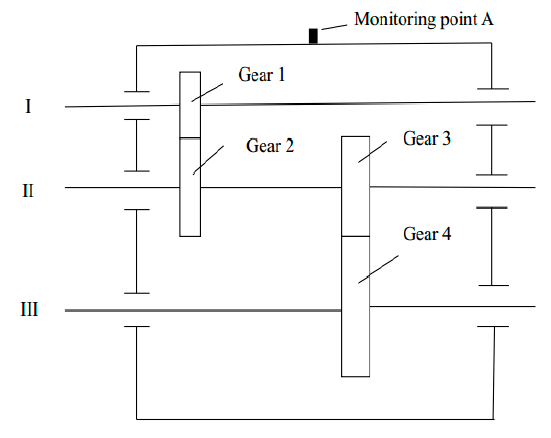
Figure 15. The no.3 fan gearbox structure schematic